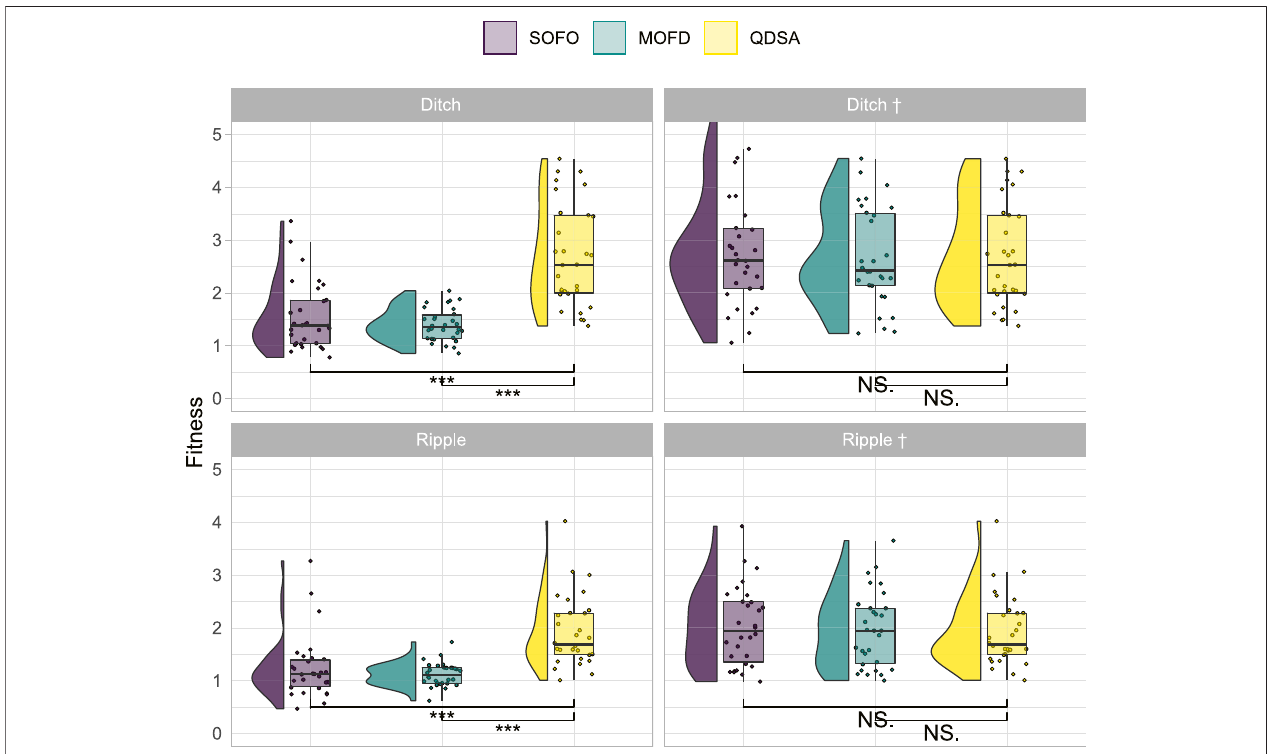
FIGURE 8 | Fitness results after last evaluation for transitioning the population evolved in the default fl at environment into two new environments. In the new environment evolution iscontinued from the initial seed population for 50,000 evaluations. Names with † signify that both SOFO and MOFD was initialized with the result of QDSA from the default fl at